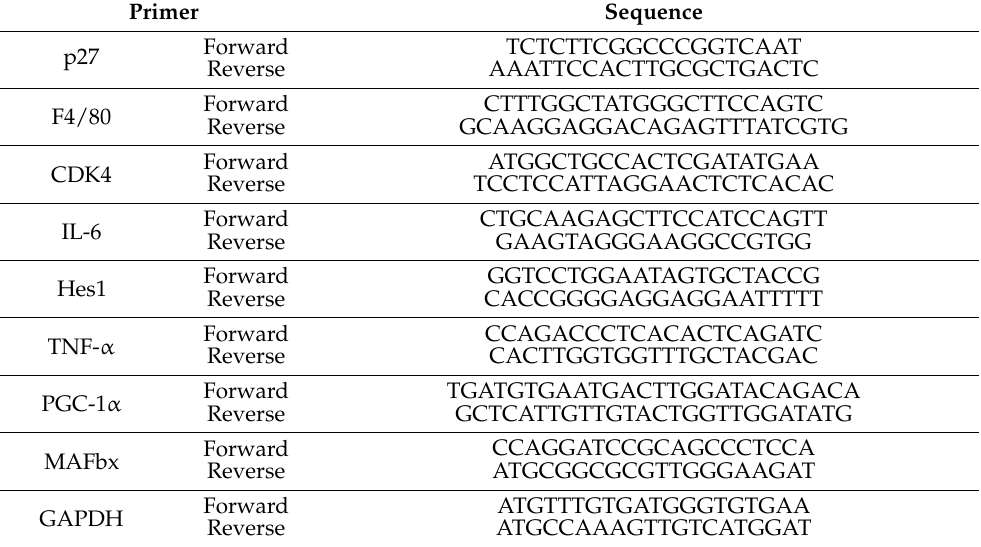
Table 2. Primers Used for Gene Expression